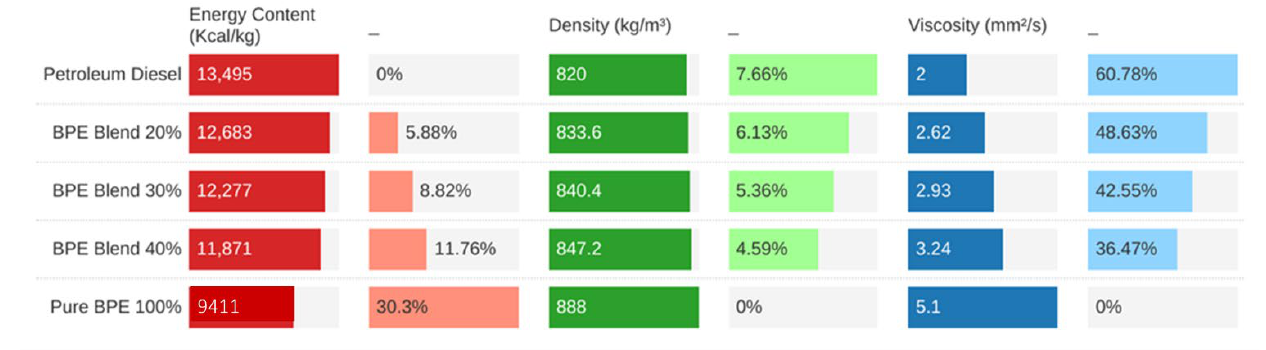
Figure 3. The main properties of the biodiesel blends gradually change with increasing biodiesel content in the mixture. Table 3. Technical parameters of KM186FAGET and KDE 6700 T alternator. Adapted with the permission from [59], 2022, KIPOR